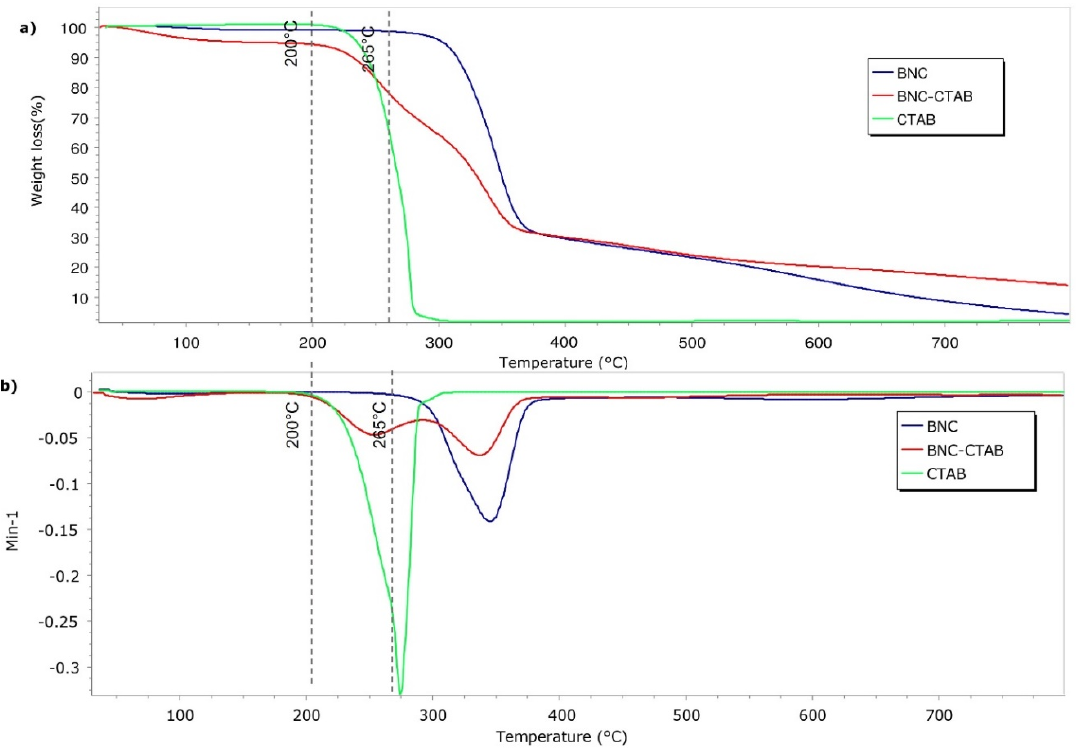
Figure 5. Thermogravimetric analysis of BNC, BNC-CTAB, and free CTAB: ( a ) TGA thermogram; ( b ) DTG curves.